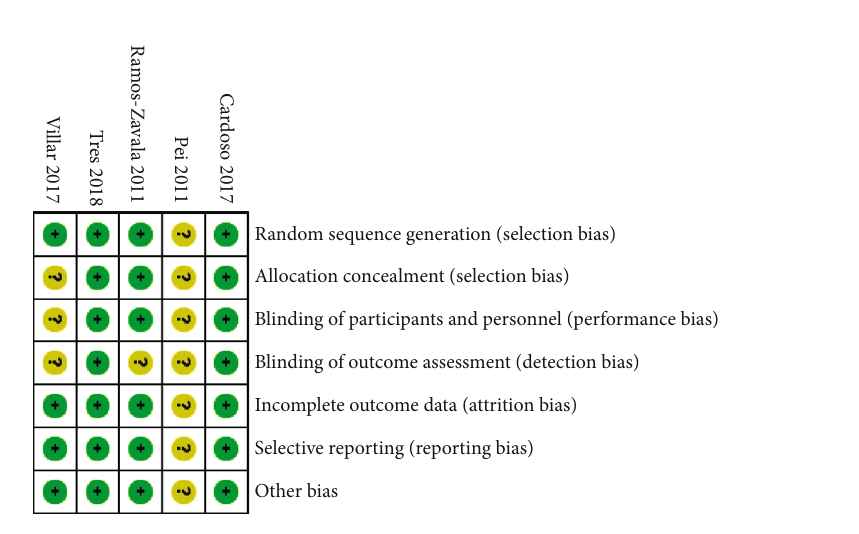
Figure 2: Risk of bias of included studies.